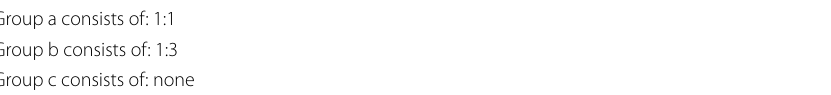
Table 40 HSD test groupings after ANOVA of AUC for the RUS factor